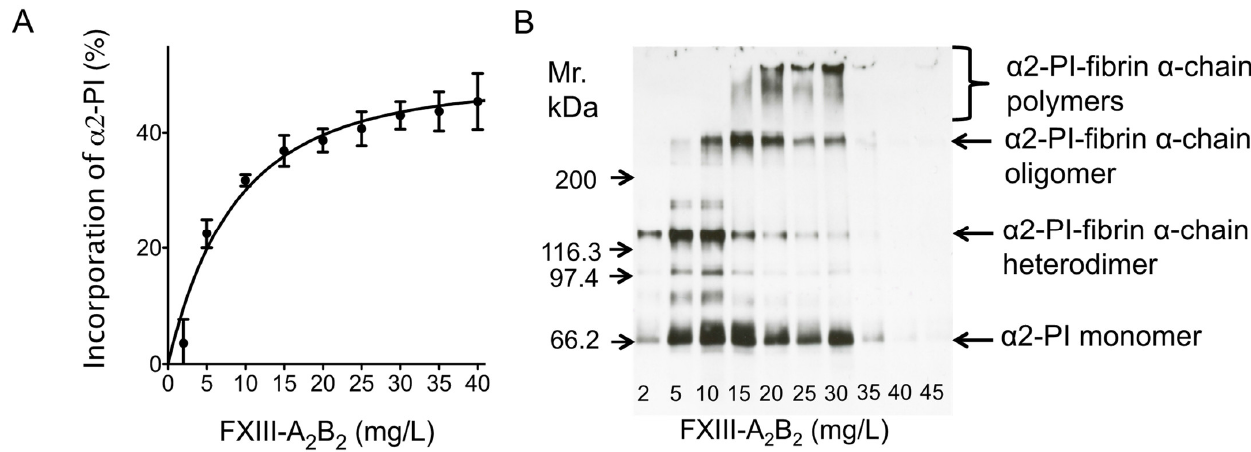
Figure 2. Effect of plasma FXIII level on the amount of α 2-PI incorporated into the fibrin clot. A FXIII-deficient plasma sample ( α 2-PI = 62 mg/L) was supplemented with different amounts of purified FXIII and clotted by thrombin and Ca 2+ . ( A ) Differences of α 2-PI antigen values between the substituted plasma and the respective serum were calculated and incorporation was presented as a percentage of the respective plasma value. ( B ) Fibrin clots were washed, dissolved and analyzed by SDS PAGE and Western blot using horseradish-peroxidase (HRP)-labeled polyclonal anti- α 2-PI antibody and enhanced chemiluminescence (ECL) detection.